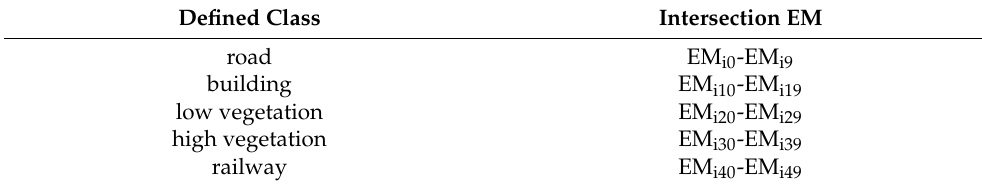
Table 1. Intersection endmember defined